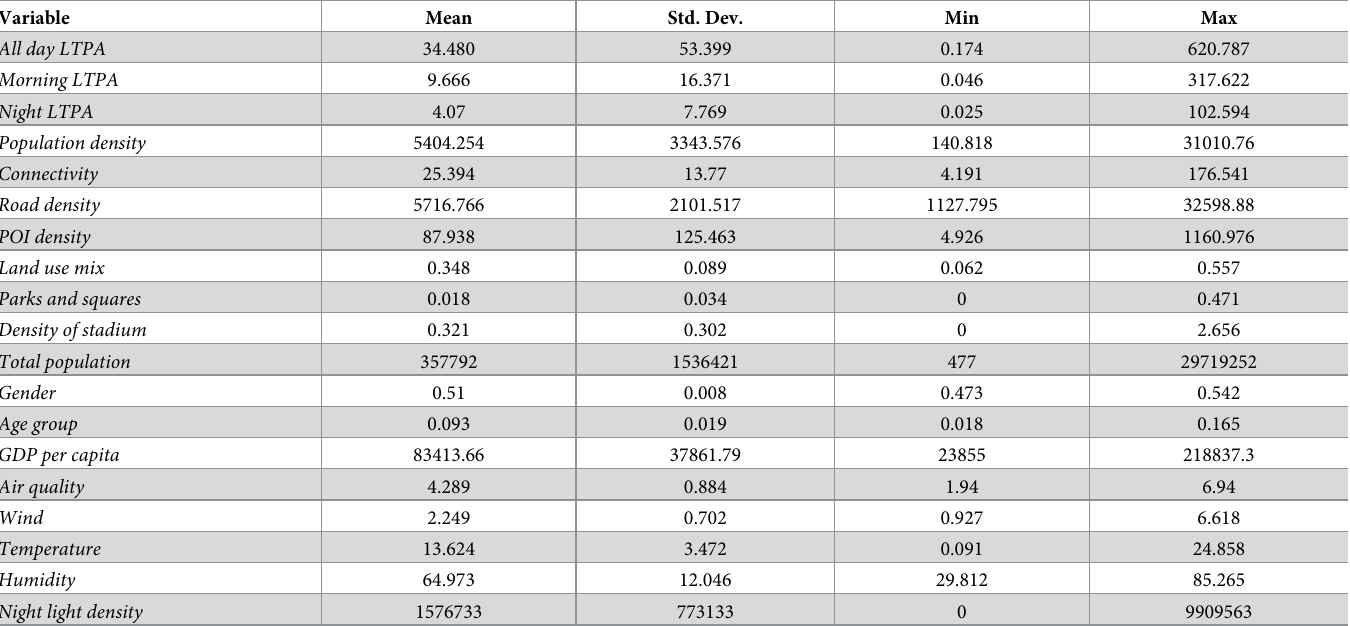
Table 2. Descriptive statistics of all the variables in the regression models. Variable Mean Std.